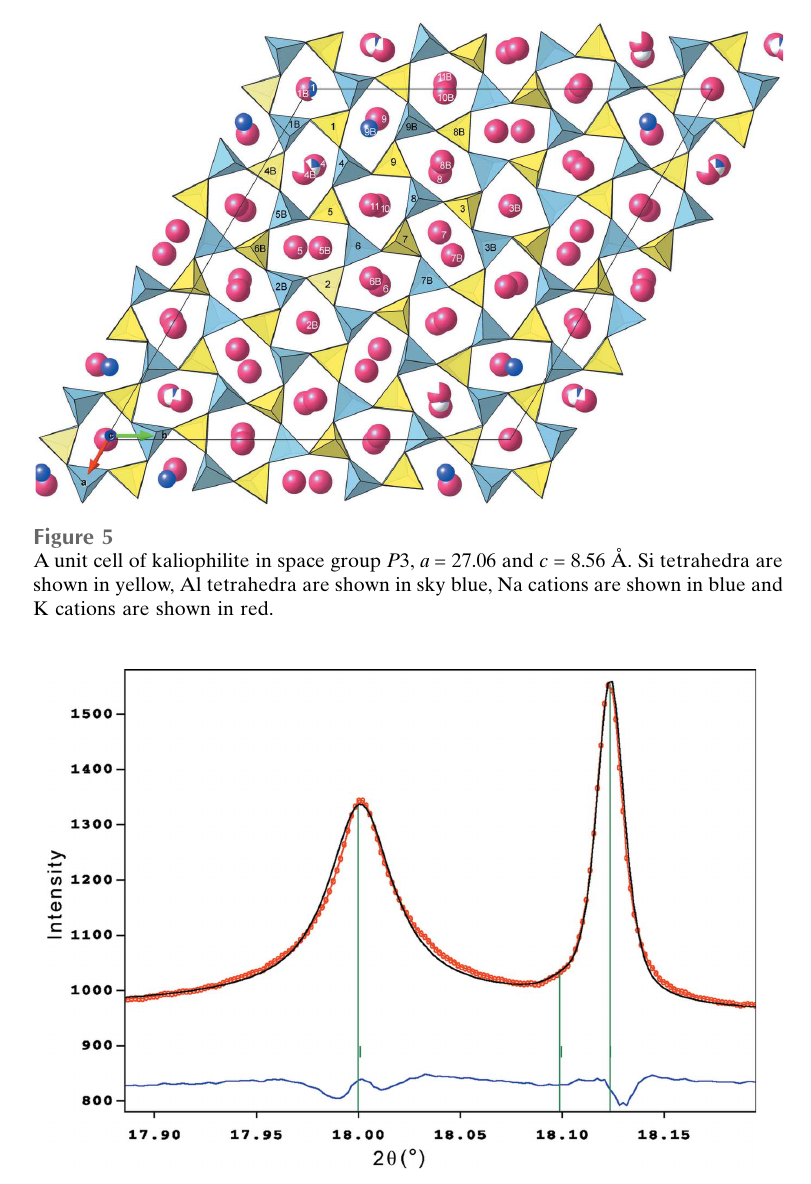
Figure 6 A Le Bail fit of reflections 511 (left) and 520 (right), showing the strong ALB with sharp hkl : h (cid:2) k = 3 n and broad h (cid:2) k 6¼ 3 n lines. The calculated (black curve), observed (red dots) and difference patterns (blue curve below) are shown. Vertical lines indicate the Bragg positions. (cid:7) = 1.18091 A˚